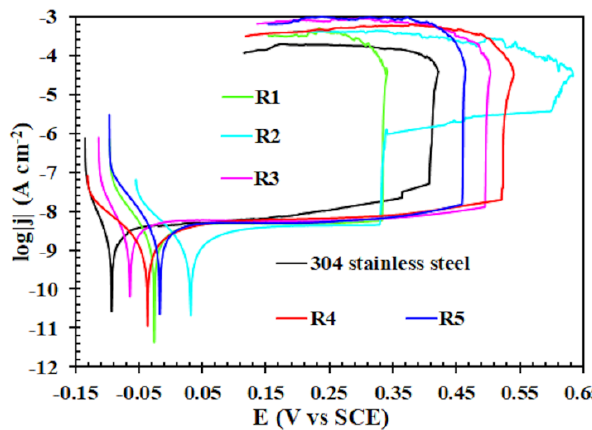
Figure 9. Potentiodynamic polarization curves of bare 304 stainless steel and samples R1–5.